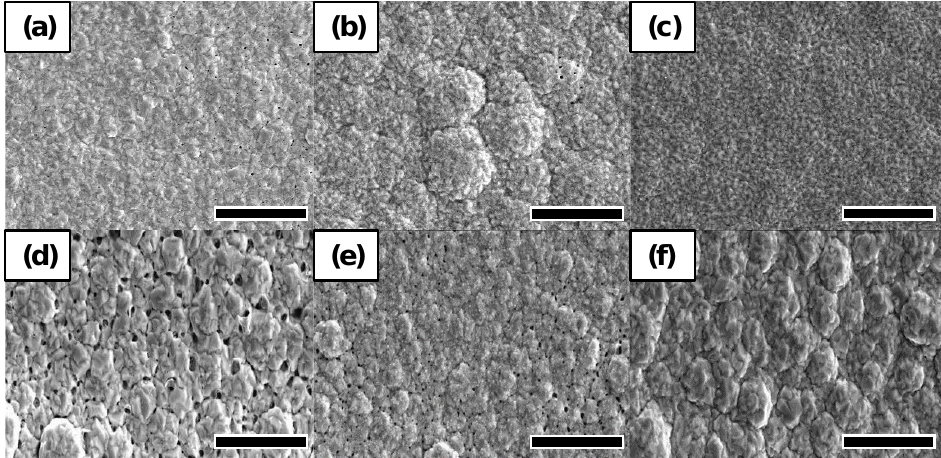
Figure 6. SEM images for Au deposition at a variety of frequencies with a duty cycle of 20% and a peak voltage of 1.5 V. ( a ) 10 Hz, ( b ) 100 Hz, ( c ) 1 kHz, ( d ) 3 kHz, ( e ) 5 kHz, ( f ) 10 kHz. Scale bar is 5 µ